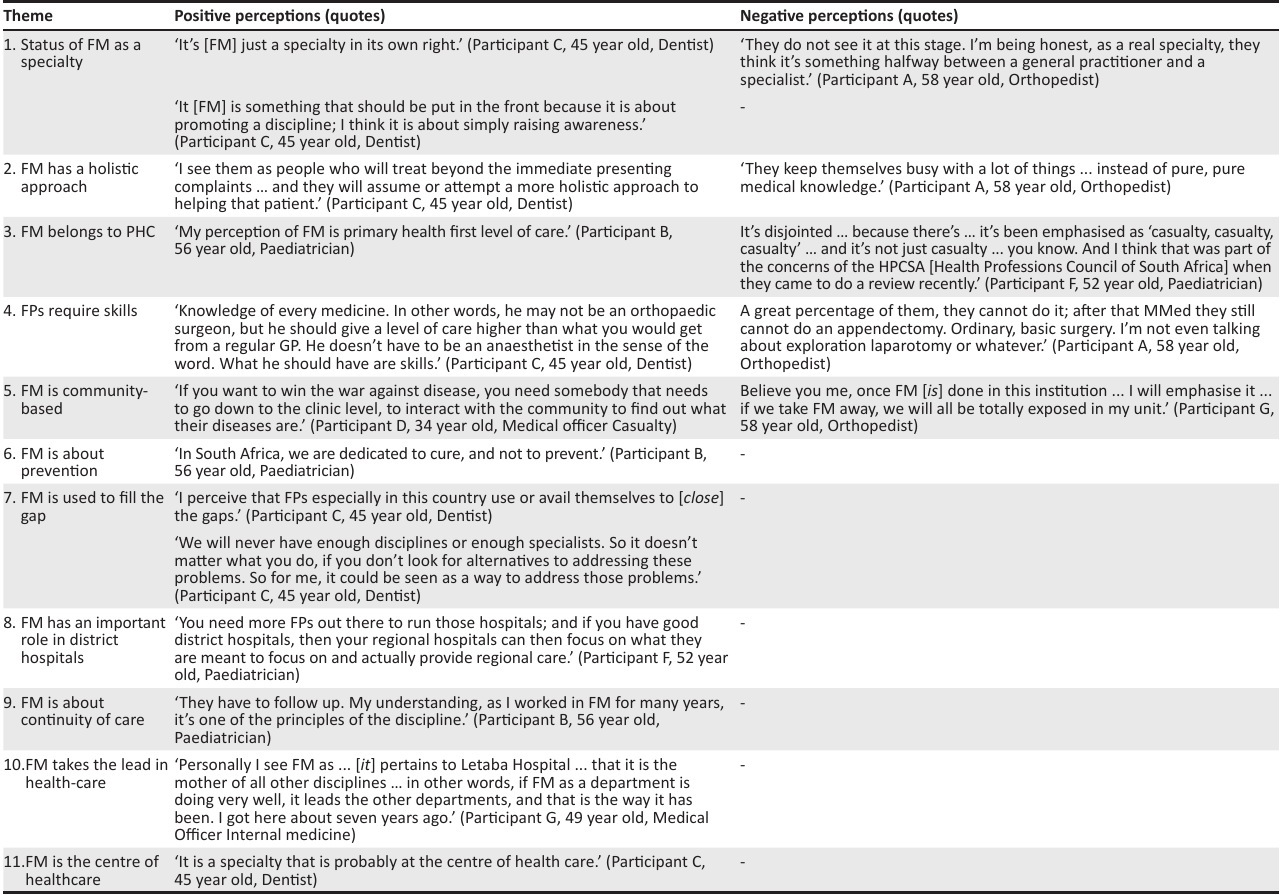
TABLE 2: Themes with negative and positive perspectives.